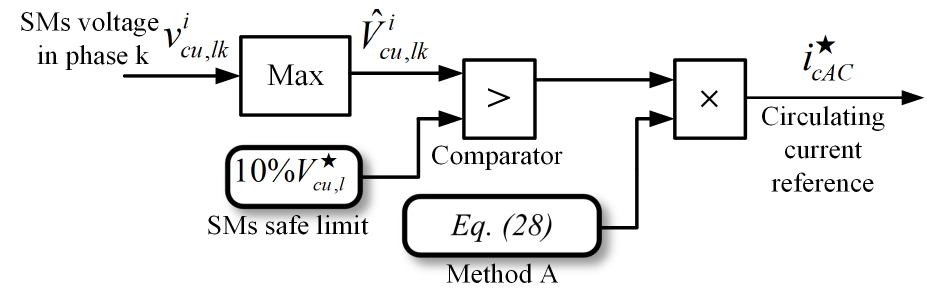
Figure 6. Block diagram of Method B.